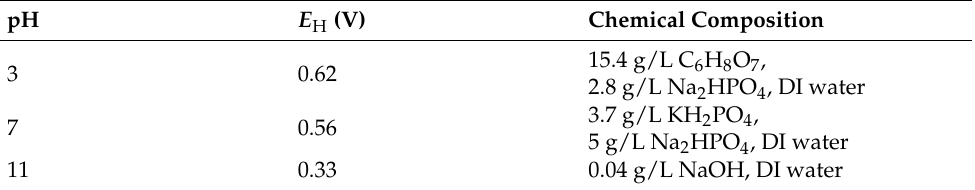
Table 1. Composition of leaching solutions with pH-values of 3, 7, and 11 used in the experiments and the measured reduction potential E H ; the same conditions as in [10]. (Copyright (2017) The Japan Society of Applied Physics, reproduced with